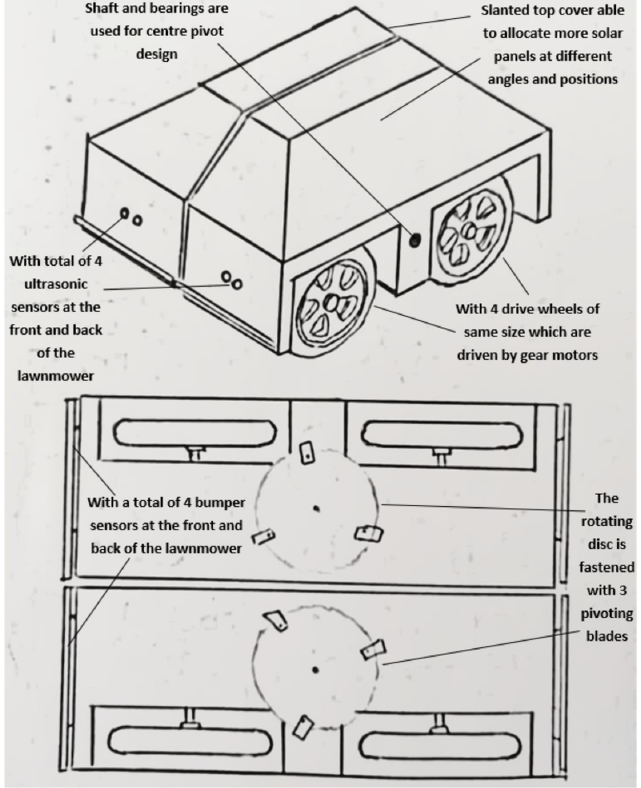
Shell Shell Shell Shell Shell Shell Assembly Assembly Assembly Assembly Assembly